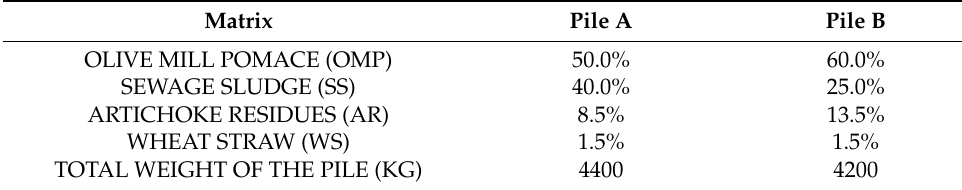
Table 3. Composition of the piles used in the experiment in percentages.